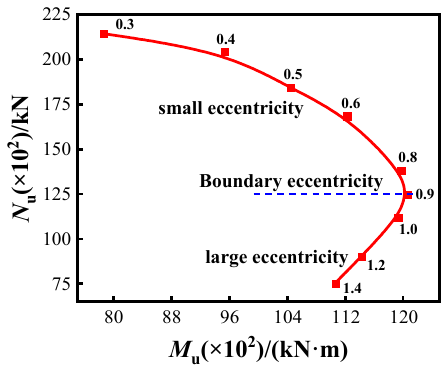
Figure 24. N–M curves of different eccentricities.